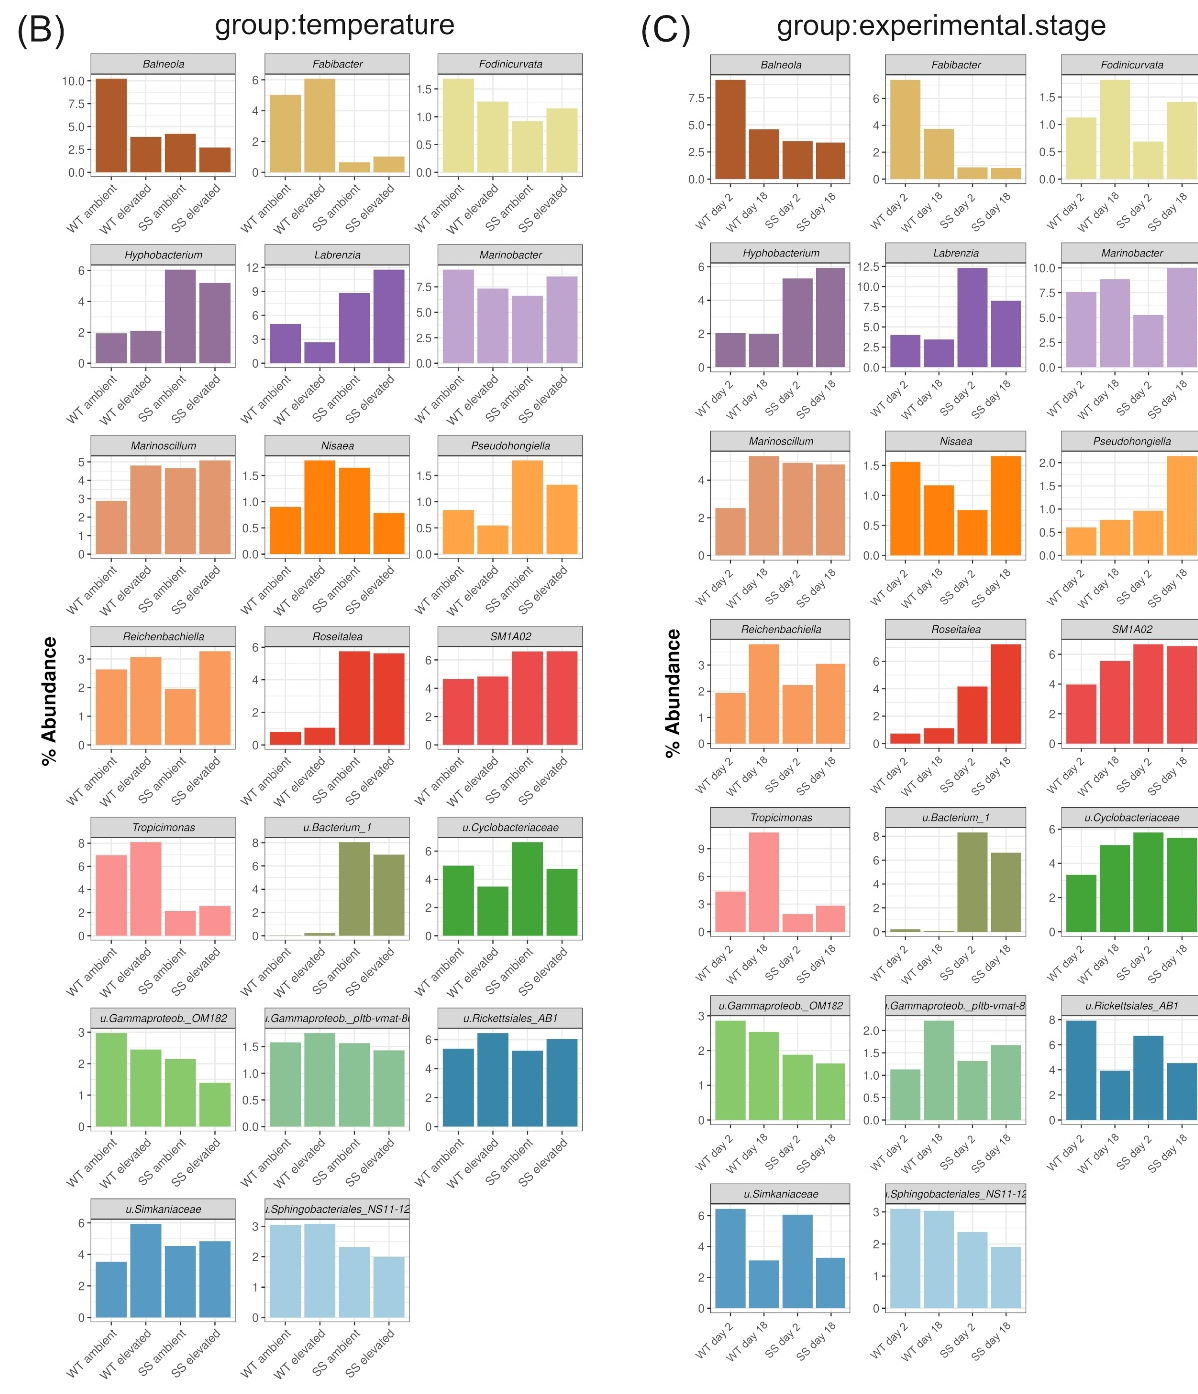
Figure 4. Barplot displaying the relative abundance [%] of the top 20 most abundant bacterial genera, which accounted for ~70–80% of the relative abundance among the strains. ( A ) Stacked barplot showing bacterial genera associated with the different strains across all time points and treatments. The remaining % to fill the bars to 100% belong to taxa not in the top 20 genera. Com- bined barplots show the interaction terms ( B ) “group:temperature”with combined time points and ( C ) “group:experiment.stage” with combined temperatures. If a genus assignment included only unassigned ASVs, the genus name was replaced with the next higher taxon level, e.g., for an uncul- tured/unassigned ASV of the Family_Simkaniaceae, written short “u.Simkaniaceae”. Number of ASVs per genera in Table